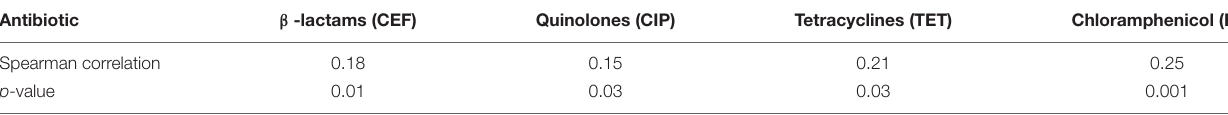
TABLE 4 | Spearman correlation analysis for OD 600 (NaClO) and MIC (antibiotic) measurements. Antibiotic